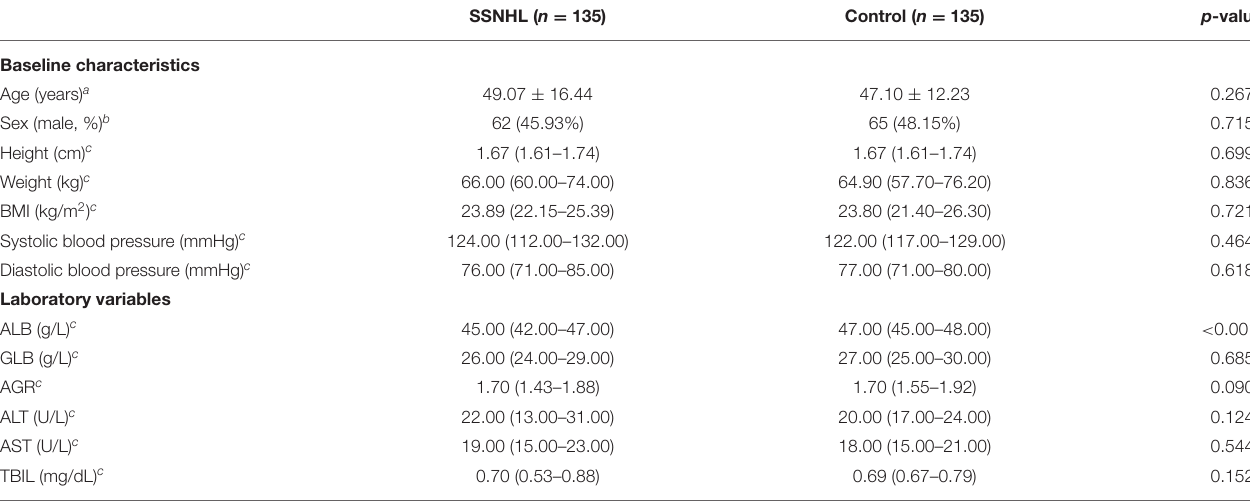
TABLE 1 | Baseline characteristics of participants in the SSNHL and control groups.